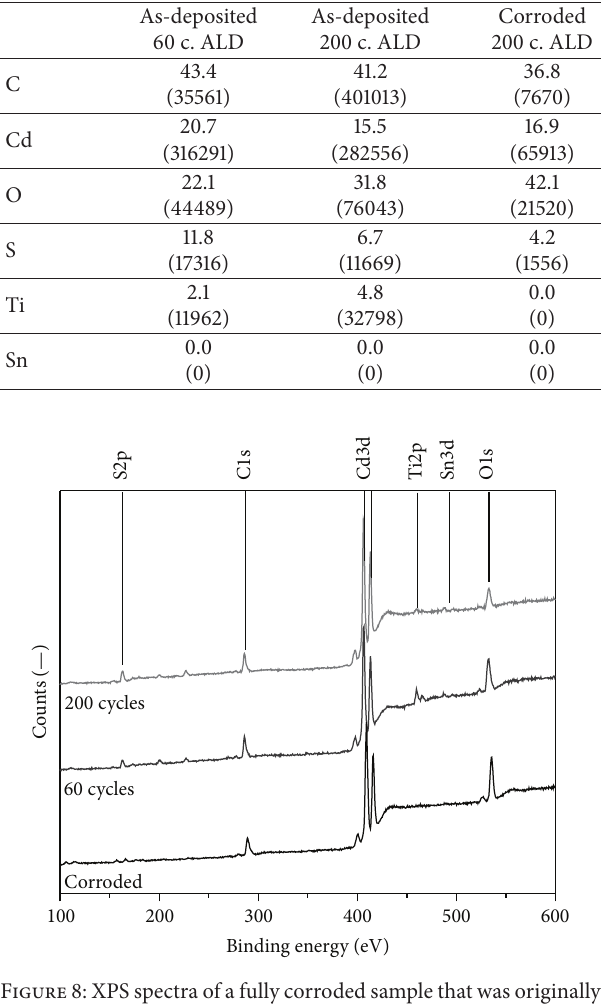
Table 1: The table gives the atomic composition of the samples. The numbers between brackets indicate surface area of the correspond- ing peaks.